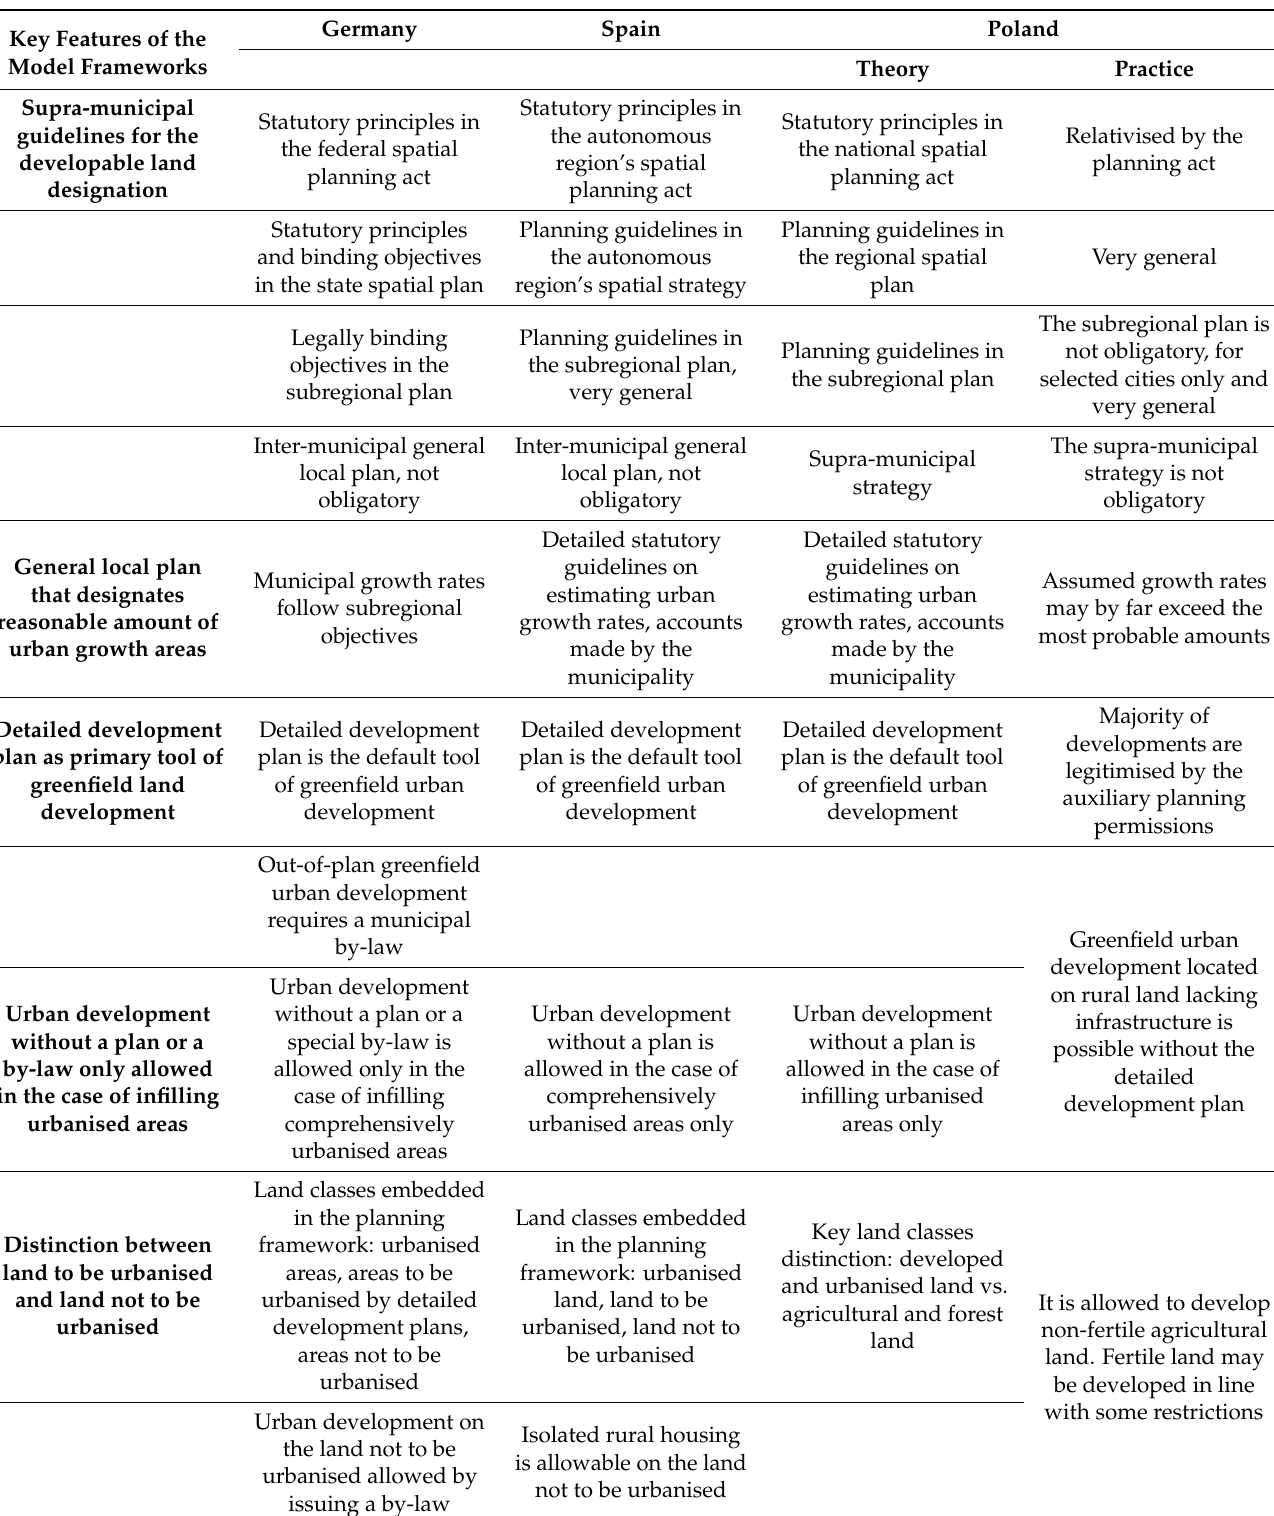
Table 1. The comparison of the key features of the investigated frameworks of developable land designation management. Key Features of